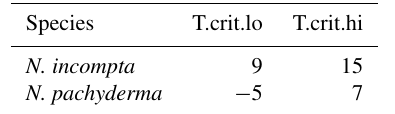
Table 2. Critical temperatures ( ◦ C) that determine the phasing of the shell flux of cold-water species. Between these two temperatures the flux pattern is characterised by two peaks a year that shift as a function of temperature to earlier in the year in warmer water (Jonkers and Kuˇcera,